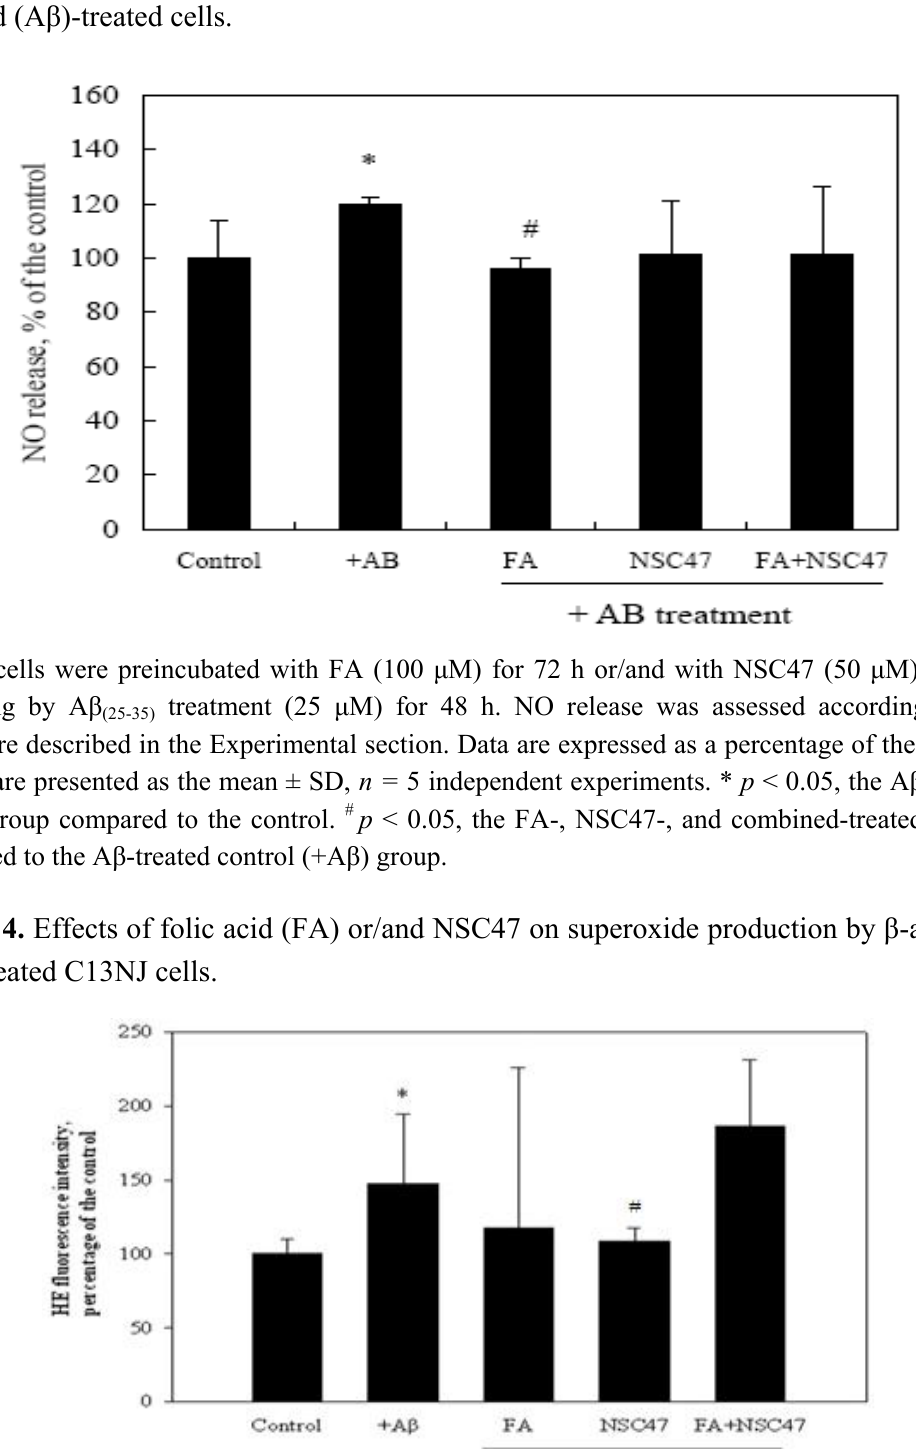
Figure 3. Effects of folic acid (FA) or/and NSC47 on nitric oxide (NO) production by β - amyloid (A β )-treated cells.